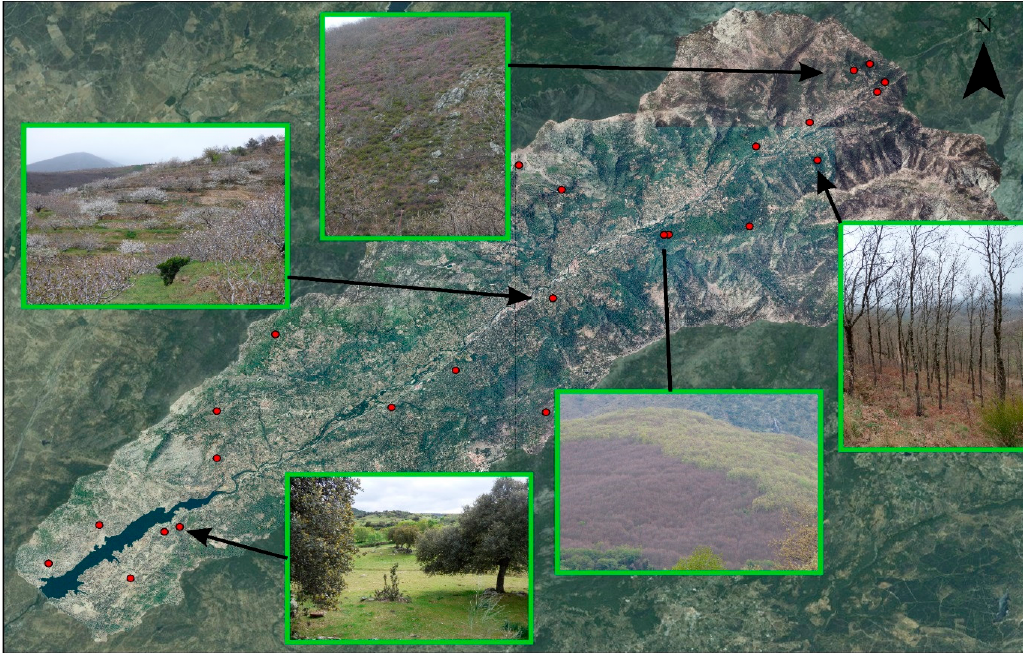
Figure 3. Situation of training areas.